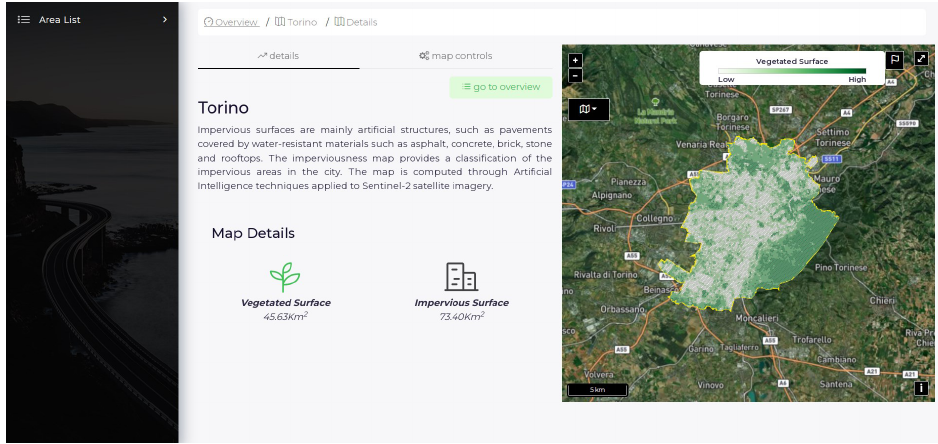
Figure 13. Example of the imperviousness map visualization into a GIS web application. In conclusion, the proposed approach shows how deep-learning, MLOPS and web- based application can effectively be used for a social-good application, such as impervi- ousness classification, in a simple and intuitive manner. The applicability of the proposed approach to different land-cover classification tasks will be tested to analyse the generaliza- tion capability of the approach across different applications. Finally, other experiments will be conducted, considering the time variable and extending the proposed dataset with new data sources, such as Sentinel-1 SAR satellite